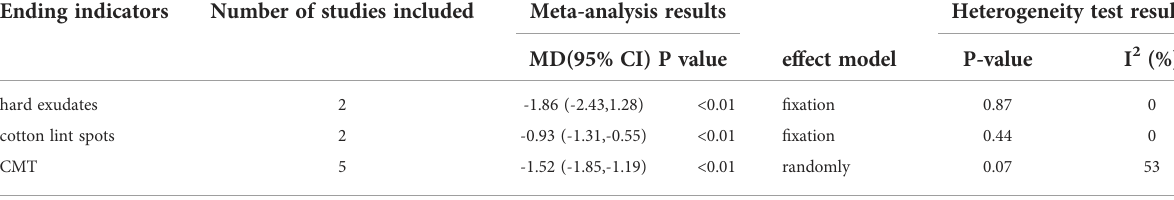
TABLE 4 Hard exudation, cotton lint spot and CMT meta-analysis